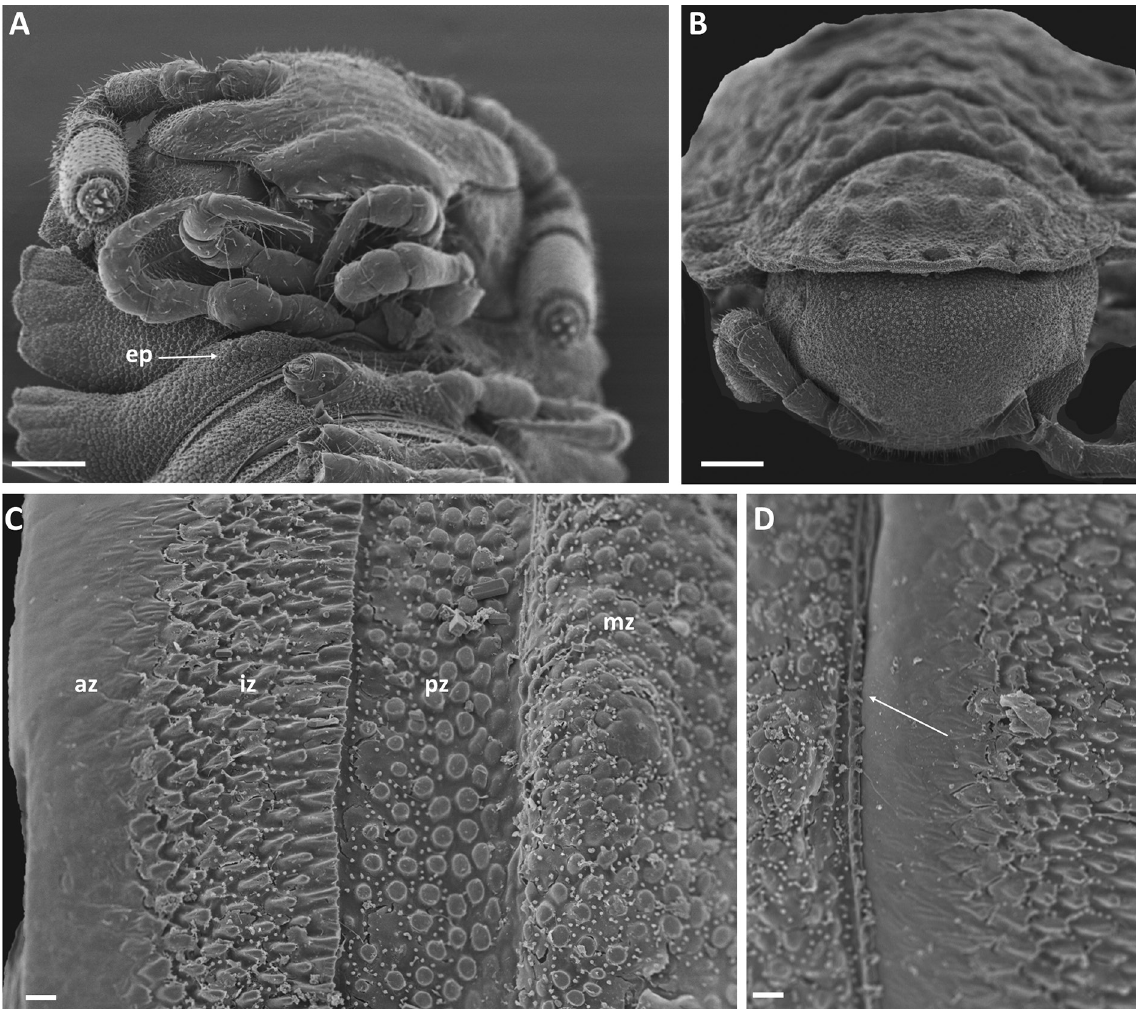
Fig. 7. Cryptocorypha geminiramus sp. nov., ♀♀, from Kidatu. A . Paratype (NHMD 621824). B–D . Paratype (NHMD 621825). A . Head and rings 1–3, ventral view. B . Head and anterior rings, anterior view. C . Prozonal sculpture. D. Limbus (arrow). Abbreviations: az = anterior zone; ep = epigynal ridge; iz = intermediate zone; mz = metazona; pz = posterior zone. Scale bars: A–B = 0.1 mm; C–D = 0.01